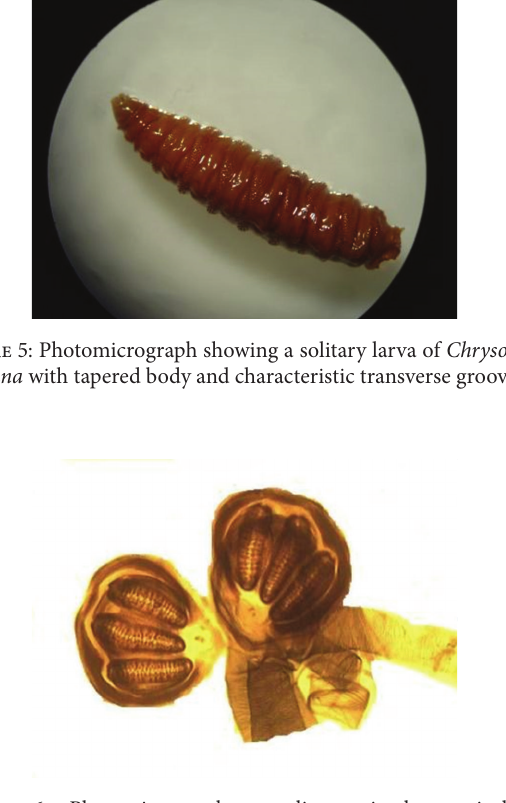
Figure 6: Photomicrograph revealing spiracles typical of Chrysomya bezziana on entomological